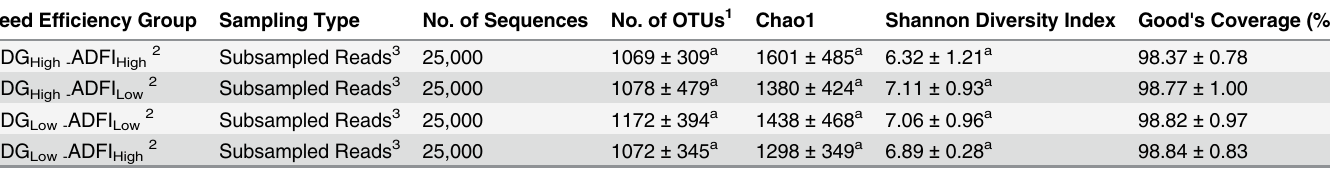
Table 1. Diversity statistics among reads from grouped samples.